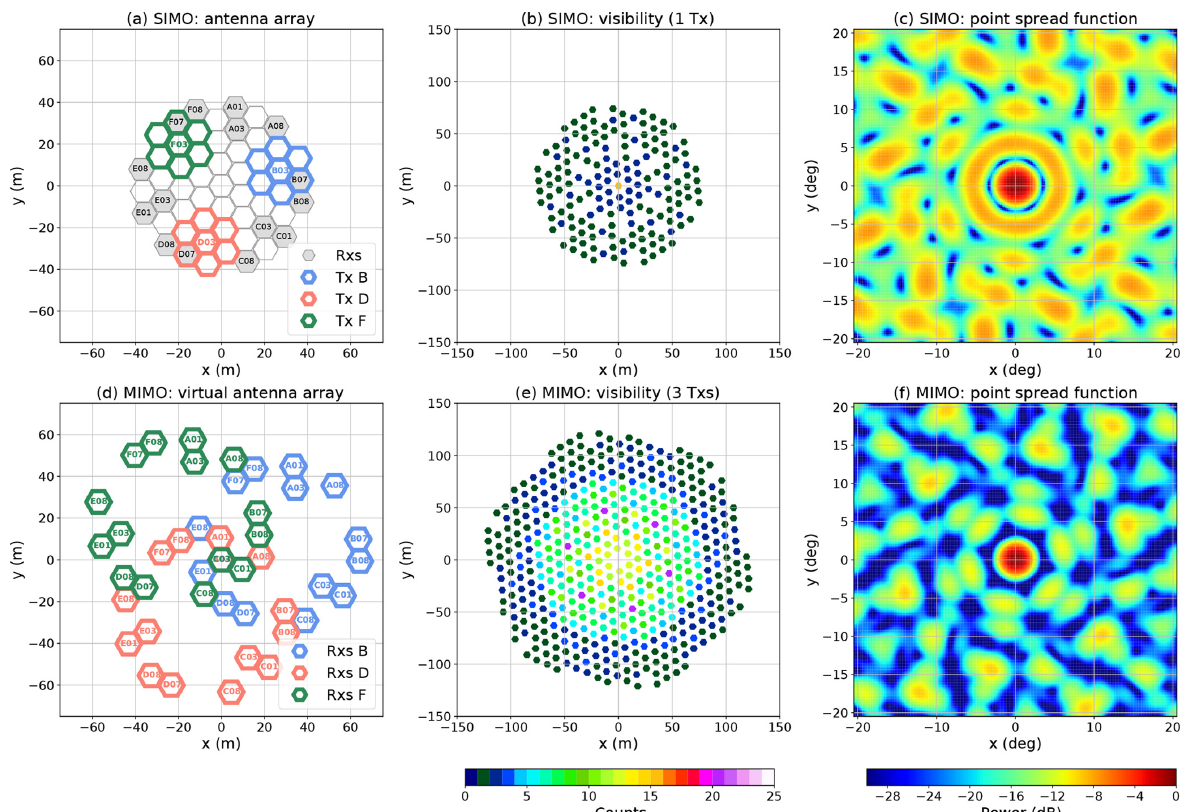
Figure 1. MAARSY antenna configuration for SIMO (a, b, c) and MIMO (d, e, f) . (a) 16 hexagons used in reception are shown in grey and three anemones used in transmission are colored. (b) Visibility samples for SIMO. (c) Point spread (or instrument) function for SIMO. (d) The virtual position of the resulting receiving antennas by using MIMO. (e) Visibility samples for MIMO. (f) Point spread (or instrument) function for MIMO. See text for further